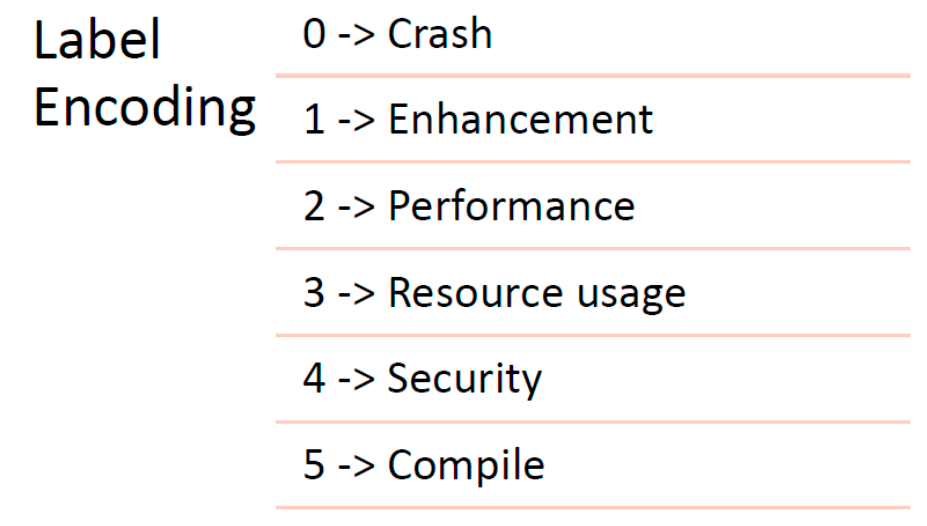
Figure 13. Label Encoding. Figure 13. Label